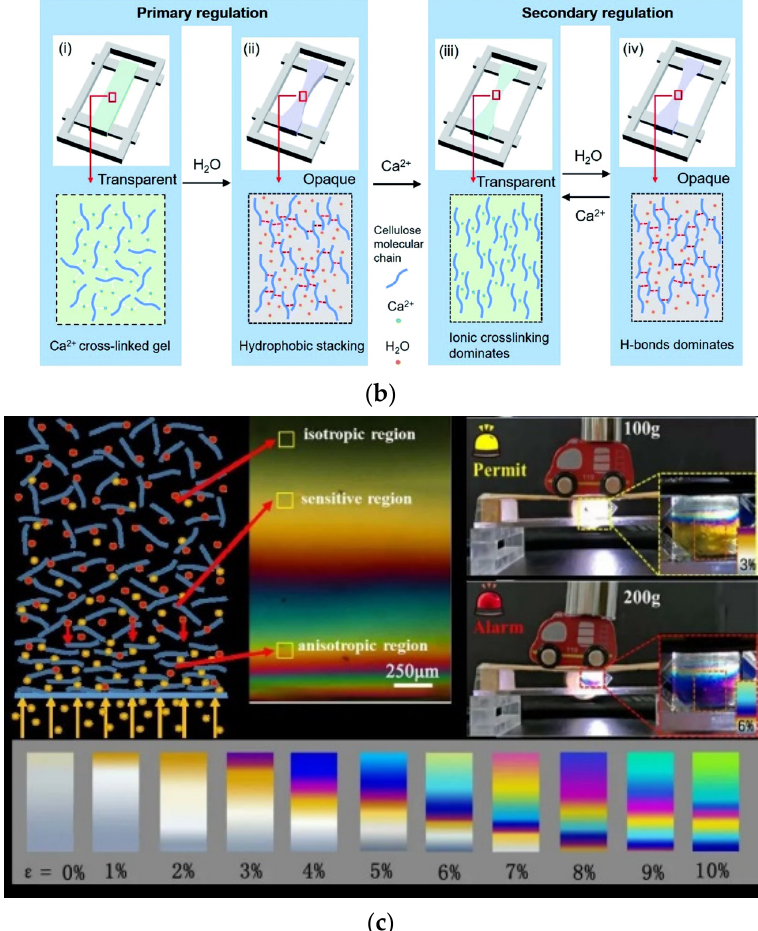
Figure 3. A new method for the preparation of anisotropic cellulose hydrogels induced by calcium ions. ( a ) Reversible multiphase transformation of Cellulose hydrogels based on Ca 2+ /Zn 2+ exchange and color change of the gel interference under orthogonal polarized light during ion exchange.